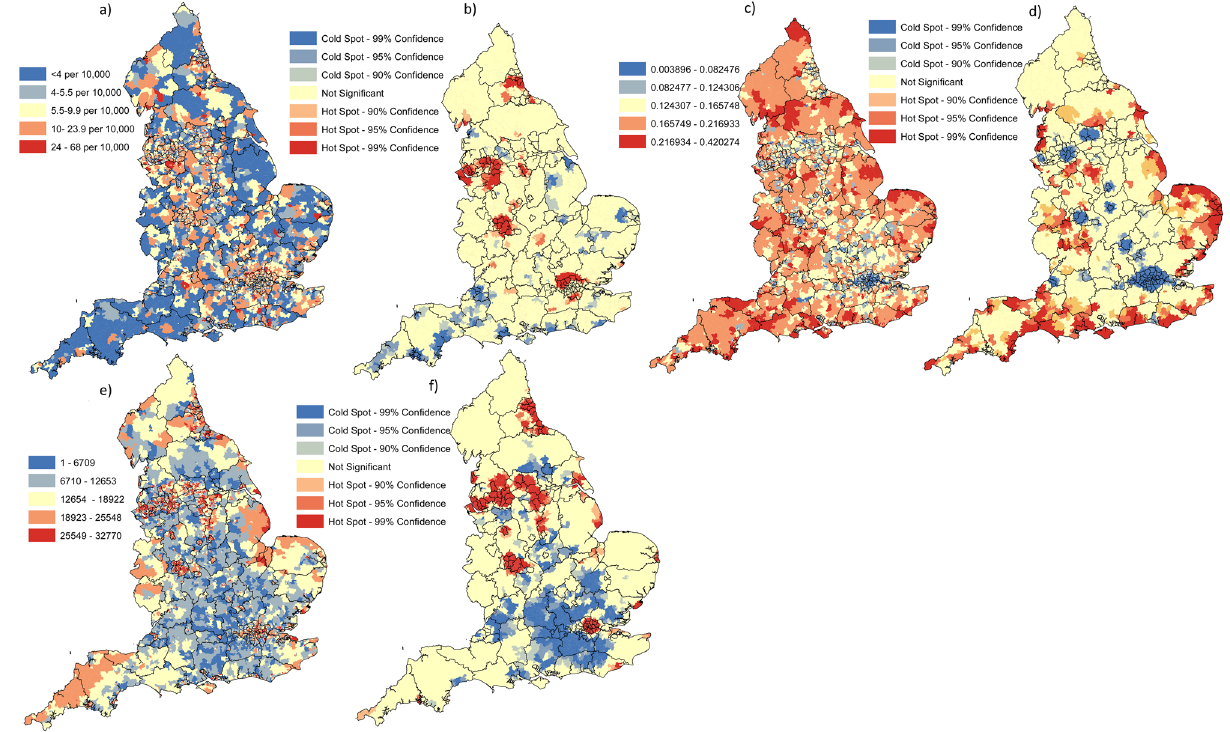
Figure 2. ( a ) Cumulative case rates at week 34 at English MSOA level (N = 6791); ( b ) statistically significant localised hot and cold spots for higher and lower cumulative COVID-19 cases at MSOA resolution at week 34 of 2020 using the Getis-Ord Gi* statistic; ( c ) proportion of population aged 70 + at MSOA resolution; ( d ) statistically significant localised hot and cold spots for higher and lower proportion of population aged 70 + at MSOA resolution using the Getis-Ord Gi* statistic; ( e ) Index of multiple deprivation at MSOA resolution; ( f ) statistically significant localised hot and cold spots for higher and lower proportion of IMD at MSOA resolution using the Getis-Ord Gi* statistic. Maps constructed using ArcGIS 10.5 (https:// deskt op. arcgis. com/ en/).